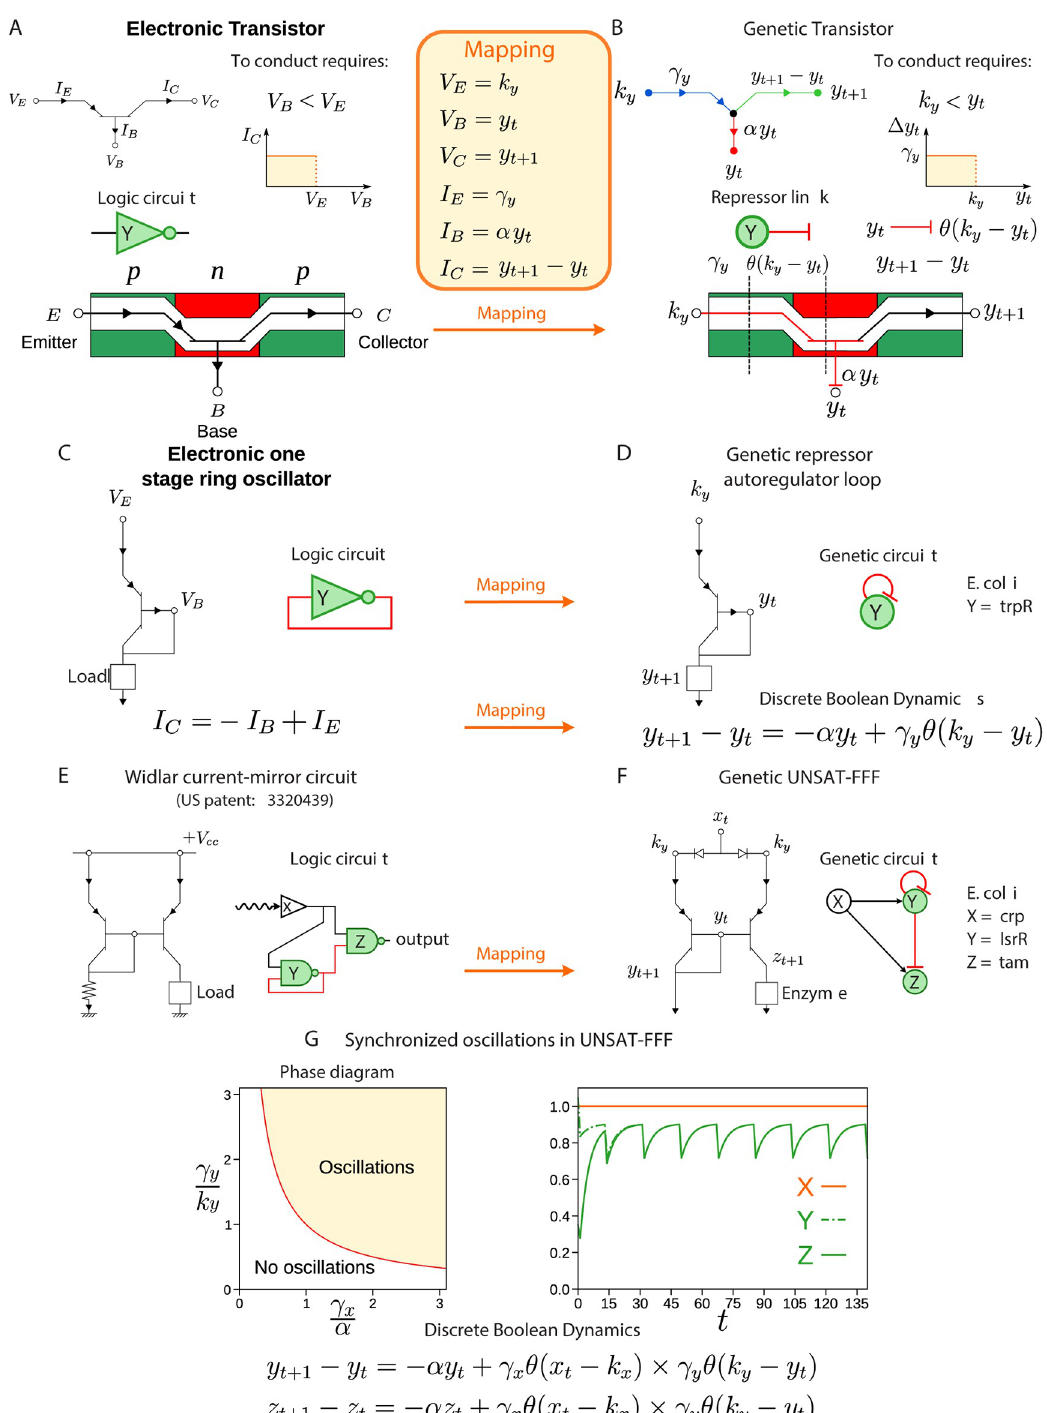
Fig 2. Mapping between electronic and biological transistor. A: A pnp transistor allows current flow if the voltage applied to its base is lower than the voltage at its emitter ( V B < V E ). Since it has a high (low) output for a lower (high) input, it is logically represented by a NOT gate. The yellow box shows the mapping between the pnp transistor and the biological repressor. B: A repressor regulation link plays the role of the pnp transistor since the rate of expression of a gene is repressed by gene Y if k C: By connecting the base of the transistor to its collector, one forms a one stage ring oscillator. D: This connection is translated to the biological analogue as a repressor autoregulation at gene Y. In this way, the rate expression of gene Y is able to oscillate,